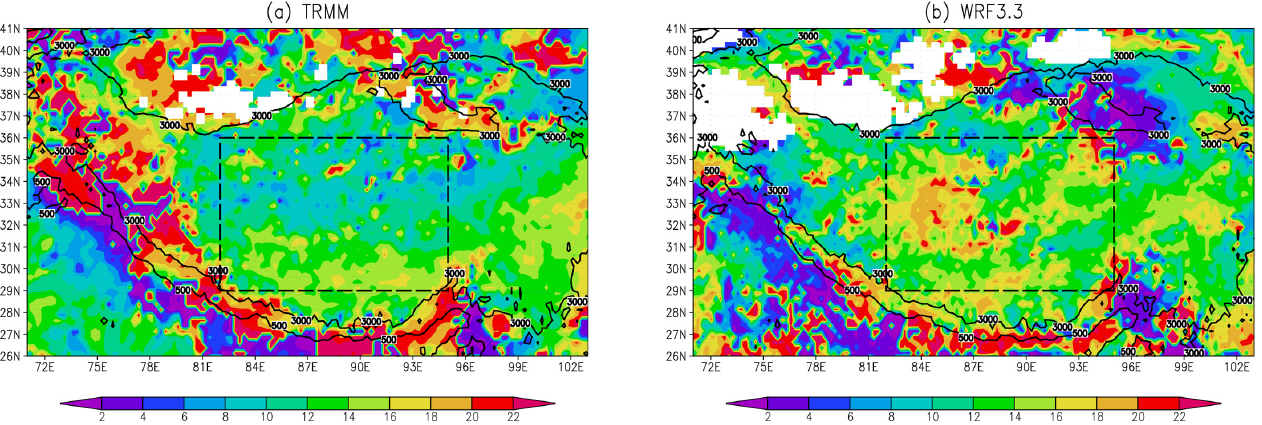
Fig. 3. Phase (UTC) of the diurnal harmonic of 3h rainfall: (a) TRMM data, (b) model simulation. Solid lines indicate the 3000 and 500m topographies, respectively. The dashed rectangles represent the central plateau.